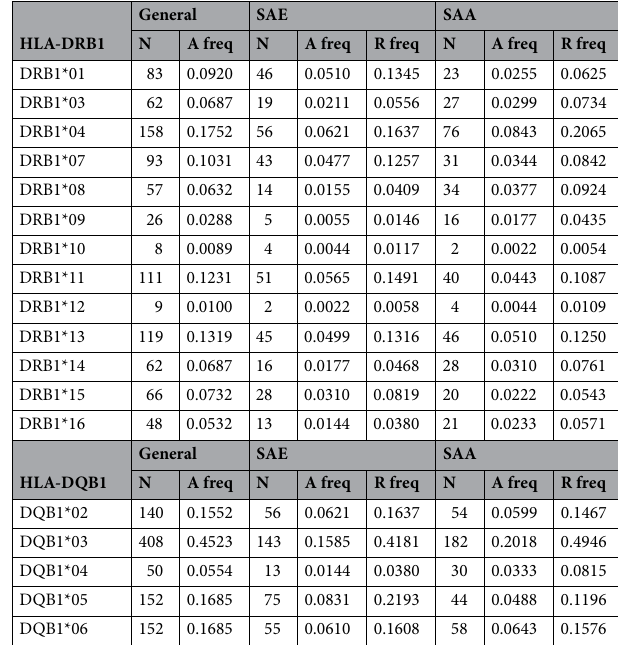
Table 3. Low resolution Class II allele frequency. Low resolution allele frequency for the general population (451 UCB units, 902 alleles), SAE group group (171 UCB units, 342 alleles) and SAA group group (184 UCB units, 368 alleles) N: Number of alleles present, A Freq: absolute frequency, R Freq: relative frequency within each